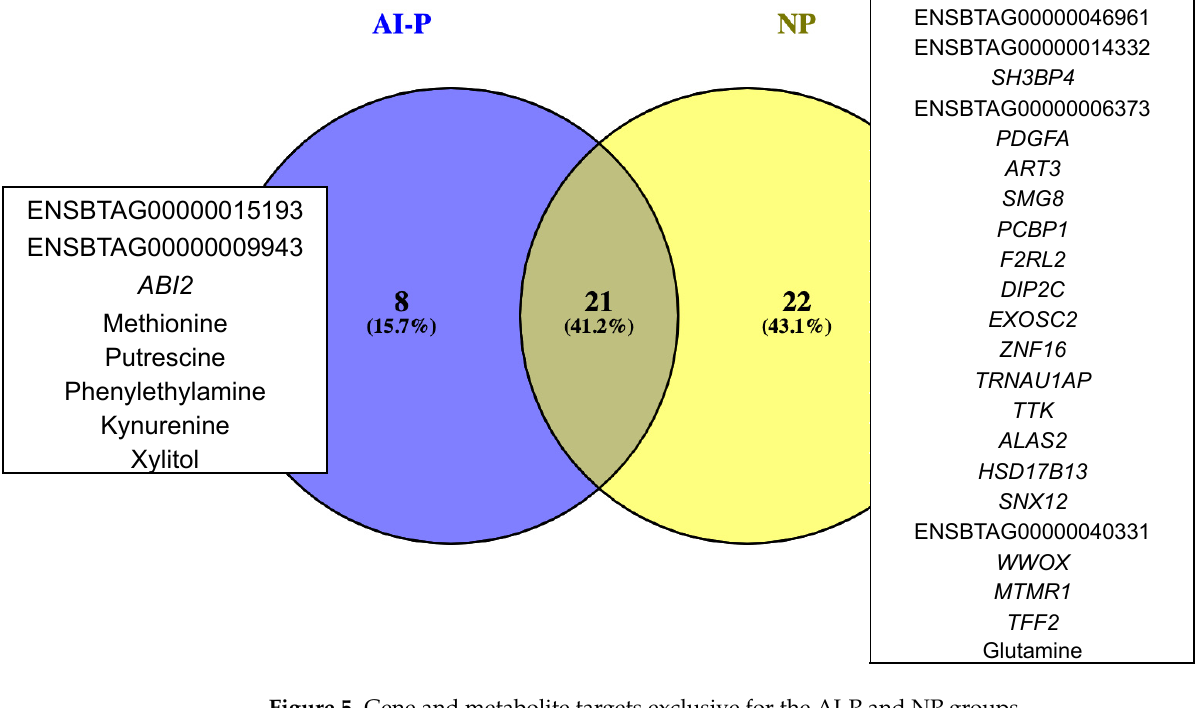
Figure 5. Gene and metabolite targets exclusive for the AI-P and NP groups.